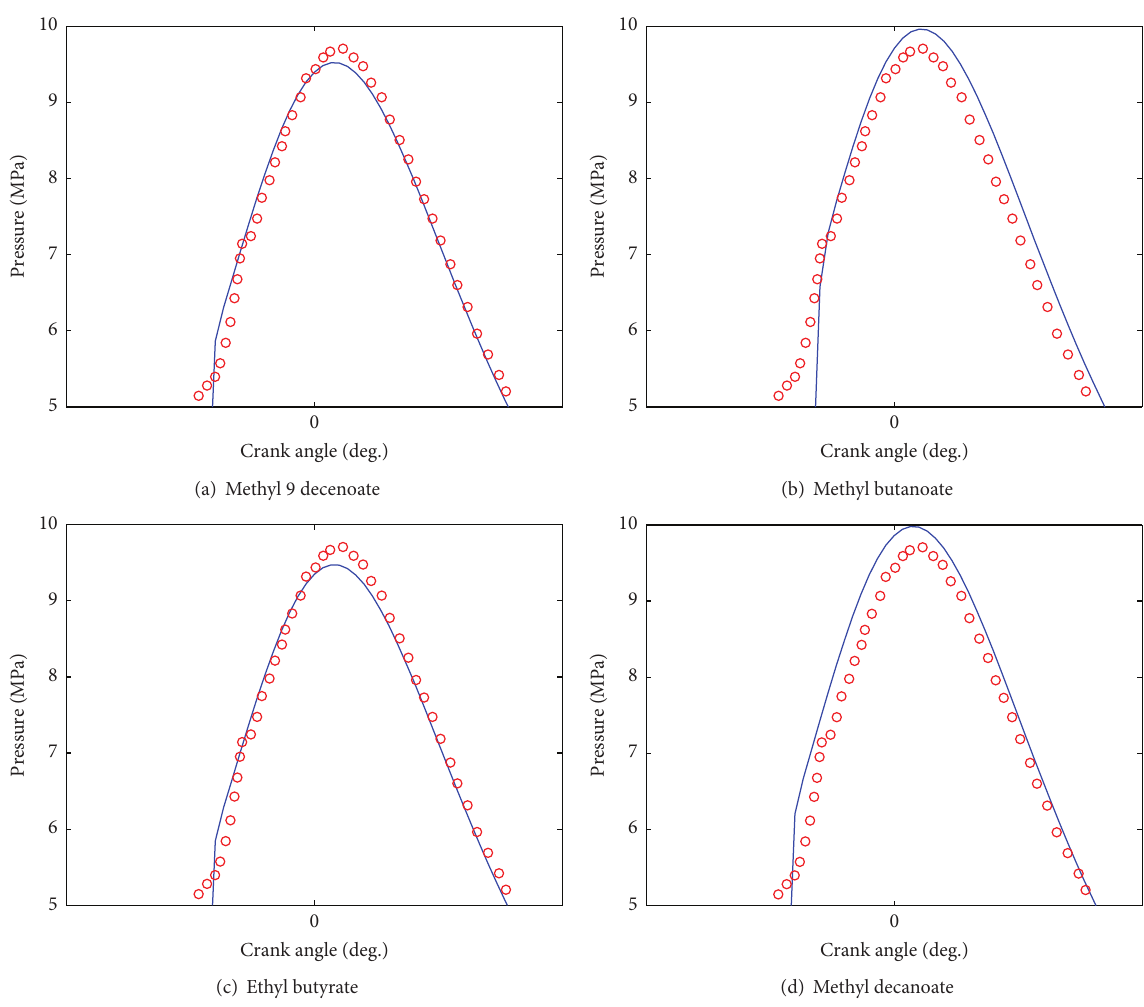
Figure 5: Experimental and simulated pressure trace at 1700 RPM for EEB for each